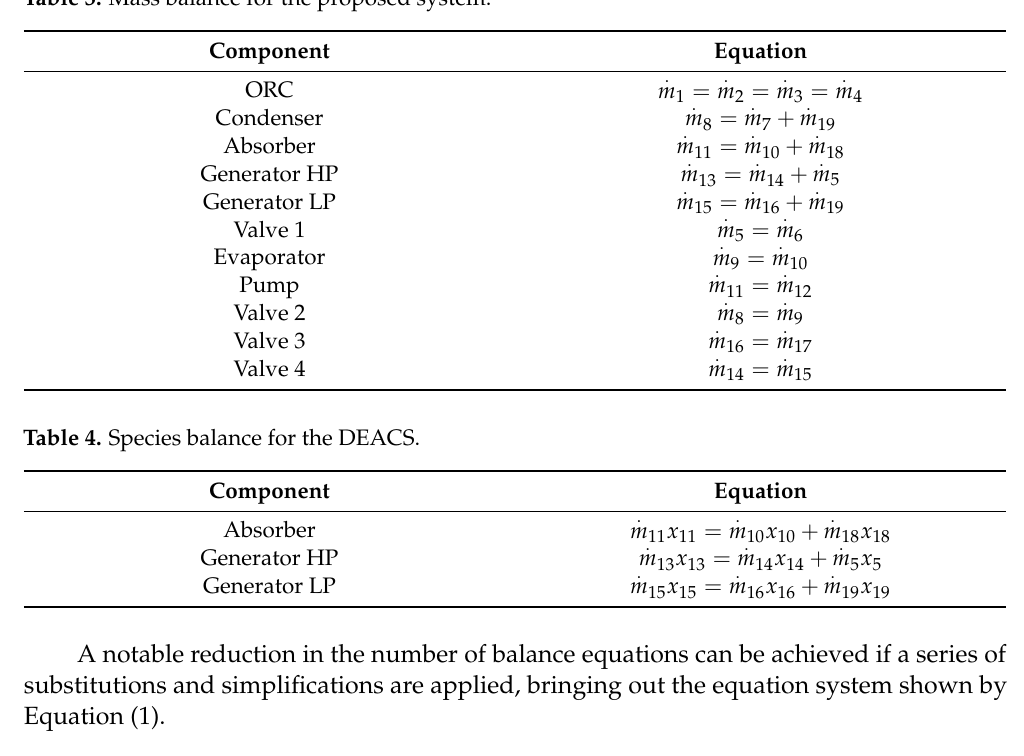
Table 3. Mass balance for the proposed system.